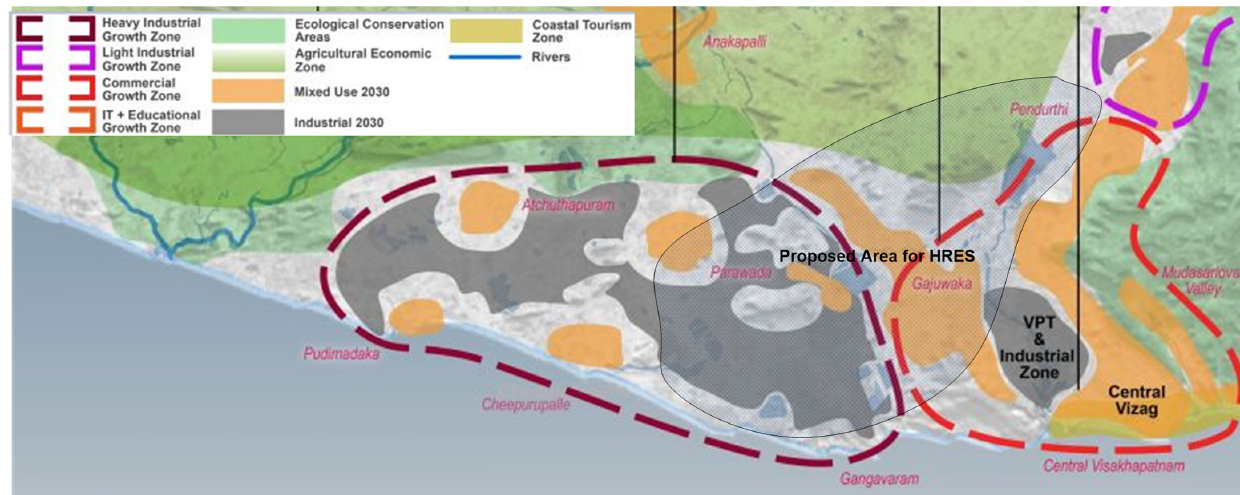
Figure 4. Growth centers and human settlements in Visakhapatnam.